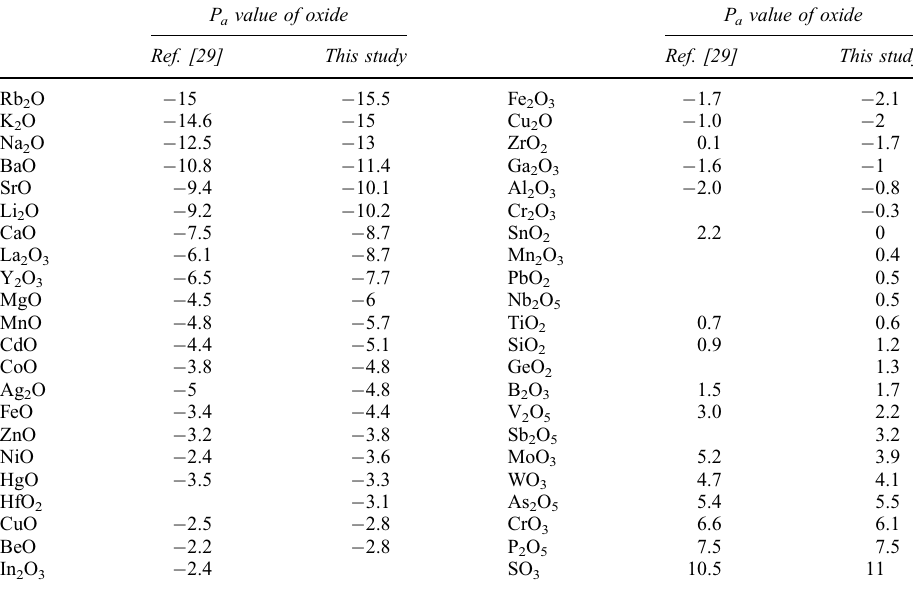
TABLE I Values of P a for Binary Oxides (Relative to H 2